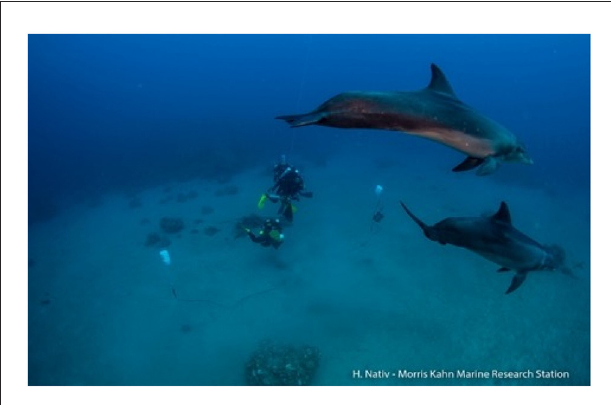
FIGURE1 The deployed acoustic recorder with dolphins inspecting the operation. Picture taken from the Eilat deployment site at depth of 50